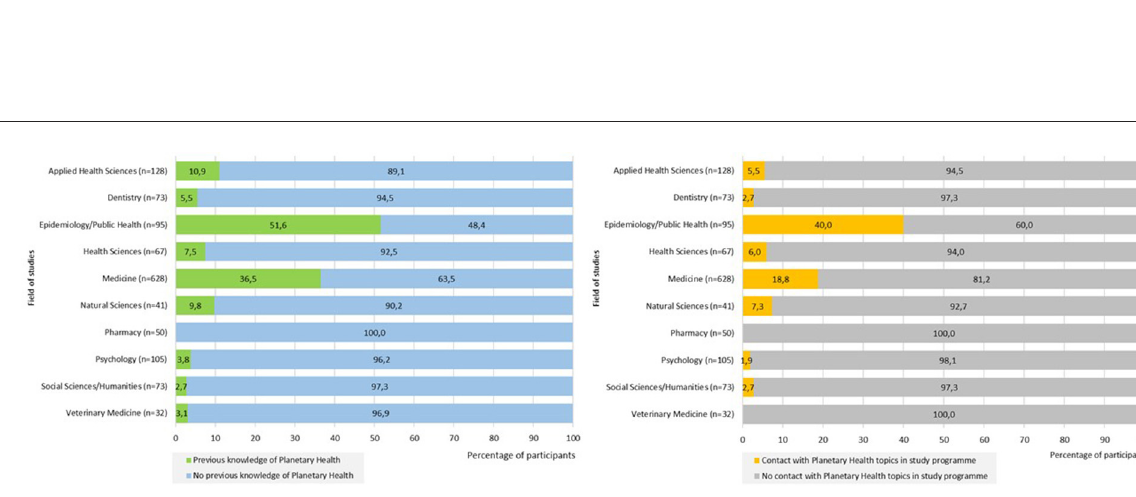
FIGURE2 Previous knowledge of and contact with Planetary Health by field of study ( N =